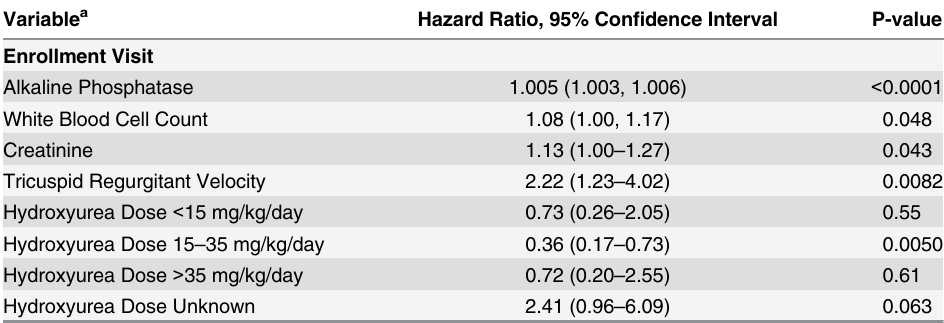
Table 3. Cox Regression Analysis of Variables Associated with Survival for Subjects with